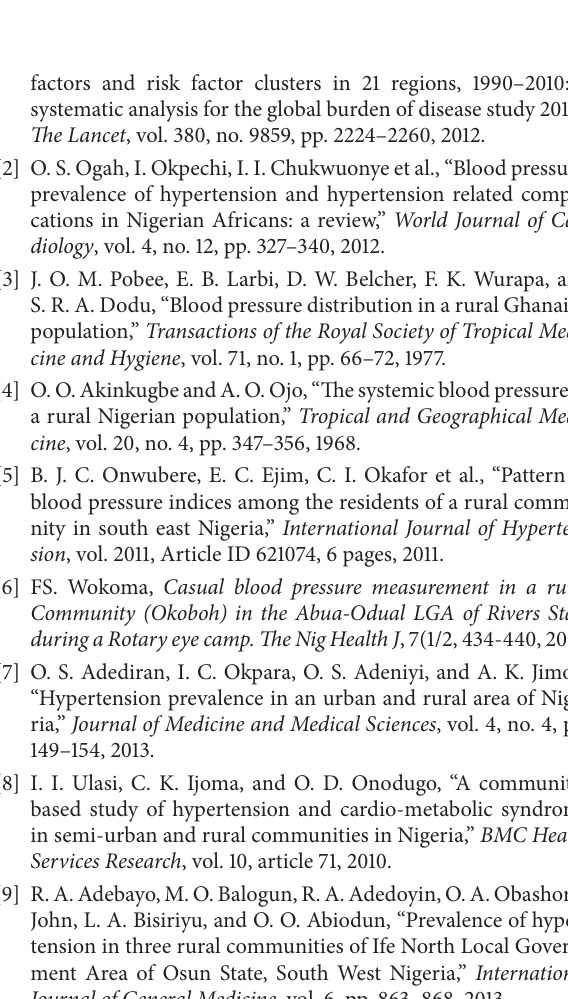
Figure 1: MABP distribution across age groups for both